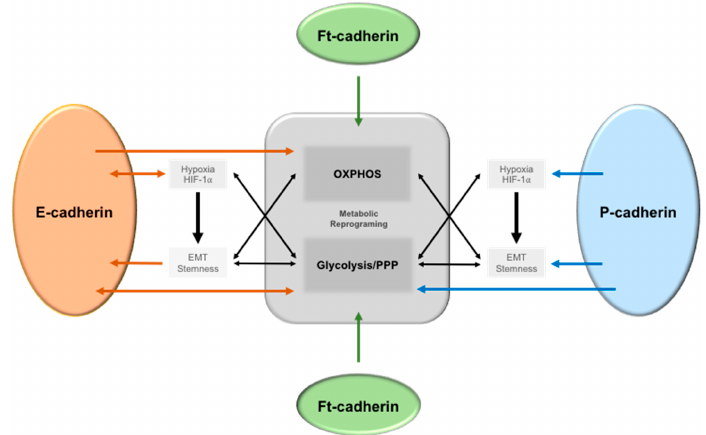
Figure 1. The crosstalk between E-, P-, and Ft-cadherin signaling and metabolic reprogramming in cancer cells. Tumor microenvironmental alterations, such as hypoxia, induce Epithelial–Mesenchymal Transition (EMT) and stem-like features in cancer cells via HIF-1 α activation, leading to an increase in glycolysis. Additionally, increased glycolysis also induces a stem and EMT phenotype, as well as a decreased E-cadherin expression. On the other hand, E-cadherin expression can also promote oxidative phosphorylation (OXPHOS) in di ff erent cancer cell models. In relation to P-cadherin expression, it is a putative EMT marker, induces stem-like properties in cancer cells, and is associated with a hypoxic, glycolytic, and acid resistance phenotype in breast cancer. Moreover, HIF-1 α induces its membrane expression, which is enriched in glycolytic BCSC. Finally, ft-cadherin is known to both enhance and inhibit OXPHOS in di ff erent